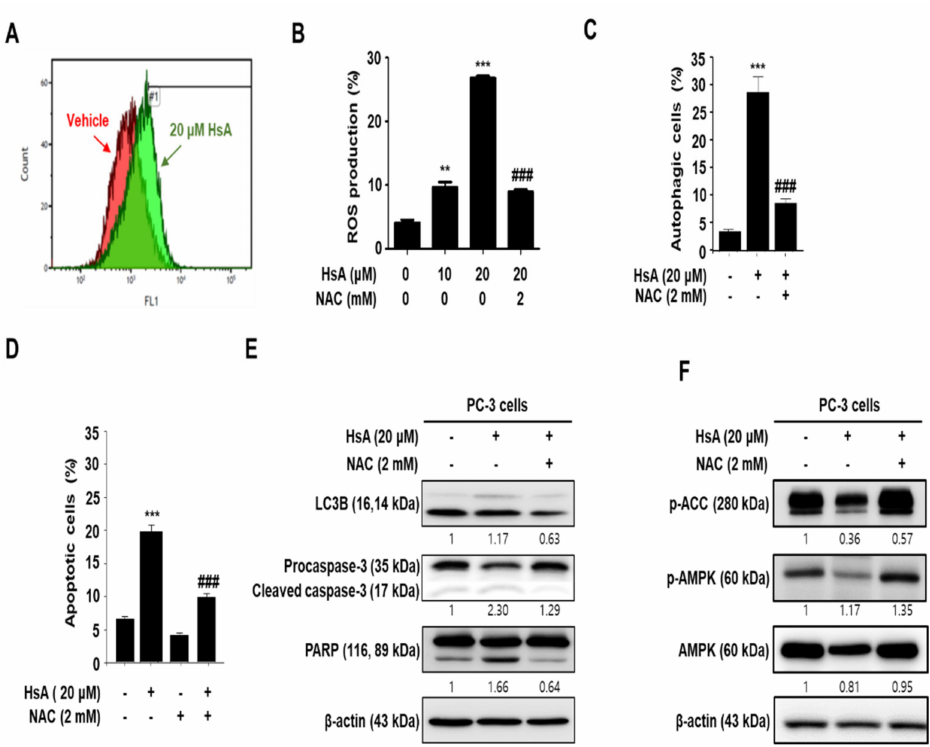
Figure 5. The production of ROS regulates Hemistepsin A (HsA)-induced autophagy and apoptosis in prostate cancer PC-3 cells. ( A ) Effects of HsA on ROS production. ( B ) Effects of NAC on HsA- induced ROS production. ( C ) Effects of NAC on HsA-induced autophagy. ( D ) Effects of NAC in on HsA-induced apoptosis. ( E ) Effects of NAC on LC-3, caspase-3 and PARP protein expression. ( F ) Effects of NAC on p-ACC and p-AMPK activation: Cells were treated with 20 µ M HsA for 24 h, with or without 2 mM NAC, and then incubated with 1 µ g/mL DCF-DA in serum-free medium for 20 min. Apoptotic and autophagic cells or DCF-DA-positive cells were detected by flow cytometry. Protein expressions were detected by western blot analysis. All data are representative of at least three independent experiments. Data show mean ± SD. ** p < 0.05, *** p < 0.001 compared with the control group; ### p < 0.001 compared with the HsA treated